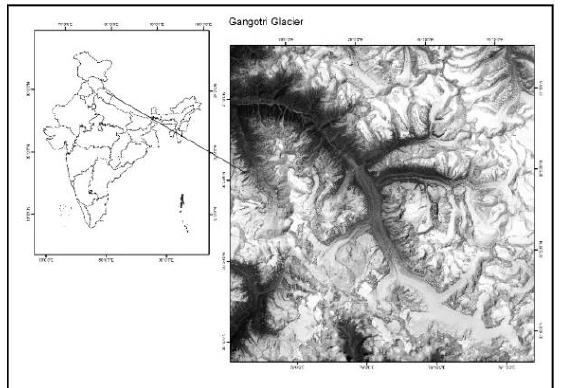
Figure 1: Gangotri glacier location map.